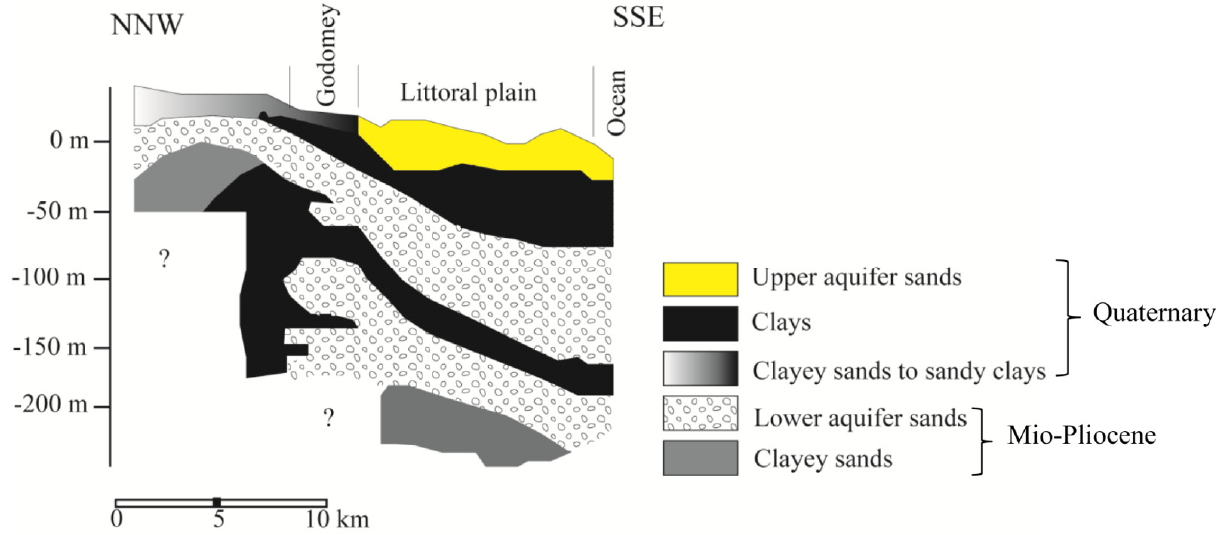
Figure 2. Longitudinal NNW-SSE geological cross section of the coastal sedimentary basin of Benin (modified from [21]). Question marks indicate levels or depths with no available data or references. Vertical axis is in meters above sea level (m asl).